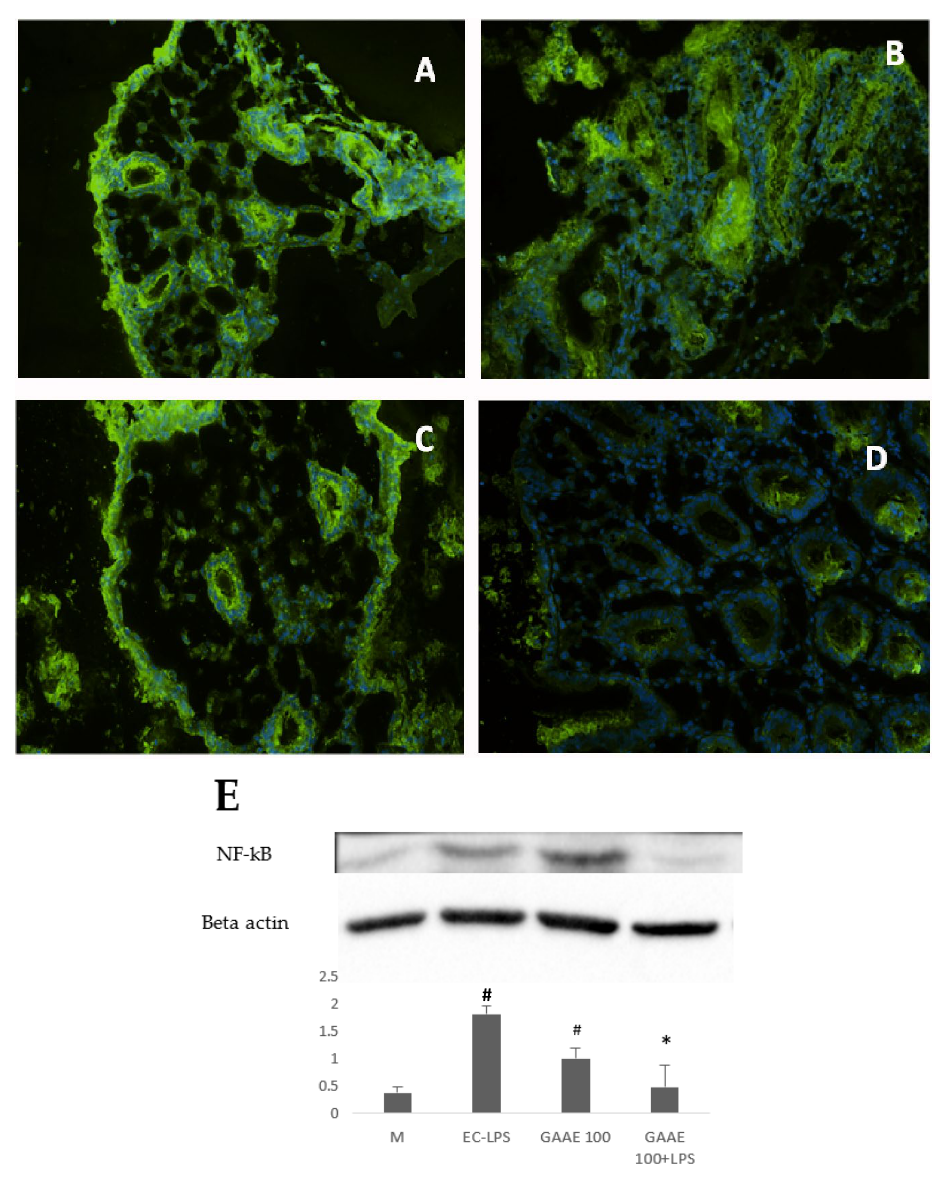
Figure 10. GAAE pre-treatment effect on NF- κ B expression in UC patient biopsies challenged with EC-LPS. ( A ) No treated biopsy; ( B ) biopsy challenged with 1 µ g/mL EC-LPS for 18 h; ( C ) biopsy treated with 100 µ g/mL GAAE; ( D ) biopsy cotreated with 100 µ g/mL GAAE and 1 µ g/mL EC-LPS; ( E ) Western blotting with the same treatments. Results are expressed as means ± S.E.M. ( N = 31), * p < 0.05 vs. EC-LPS, # p < 0.05 vs. medium (Student’s t - test).